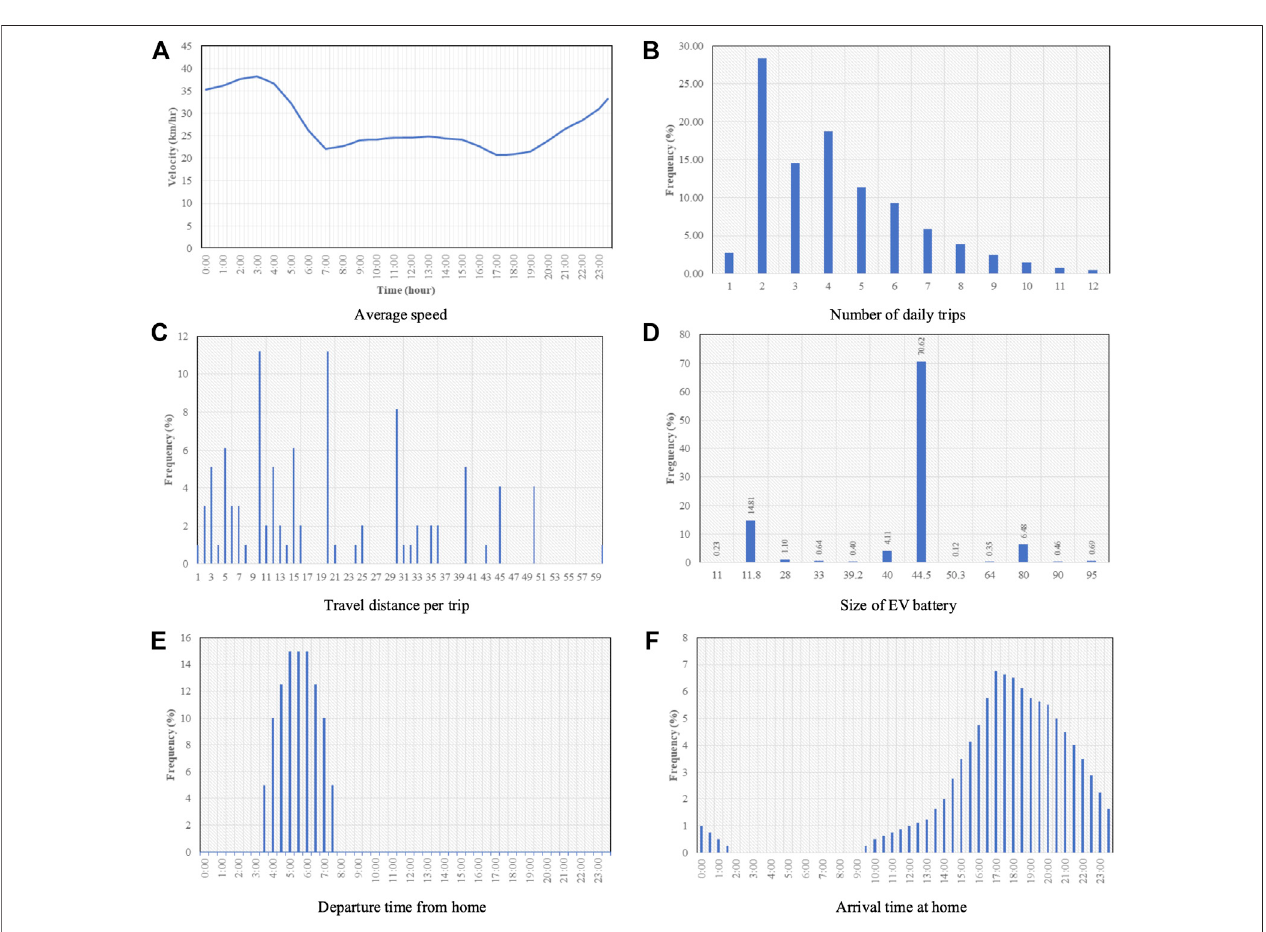
FIGURE 1 | Data sets used in Monte Carlo-based load pro fi le